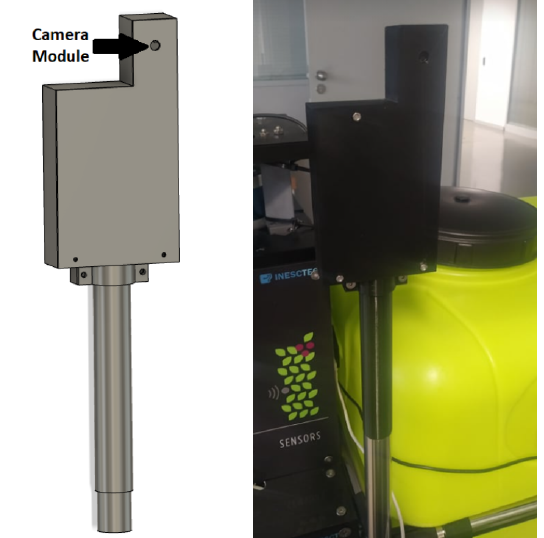
Figure 4. AgIoT support, 3D model ( left ), and final result ( right